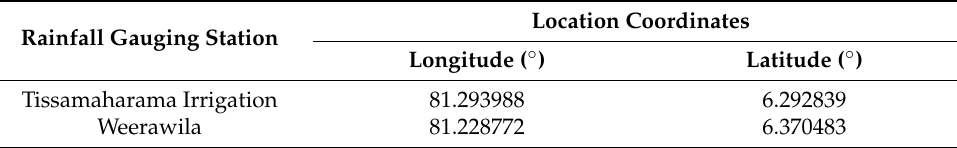
Table 1. Rainfall gauging stations within Tissamaharama DSD. Rainfall Gauging